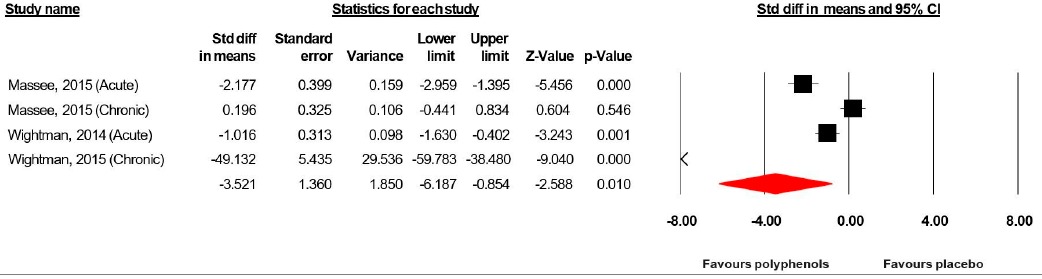
Figure 6. Forest plot of studies investigating the effect of (poly) phenol-rich supplementation on mental fatigue (MF).